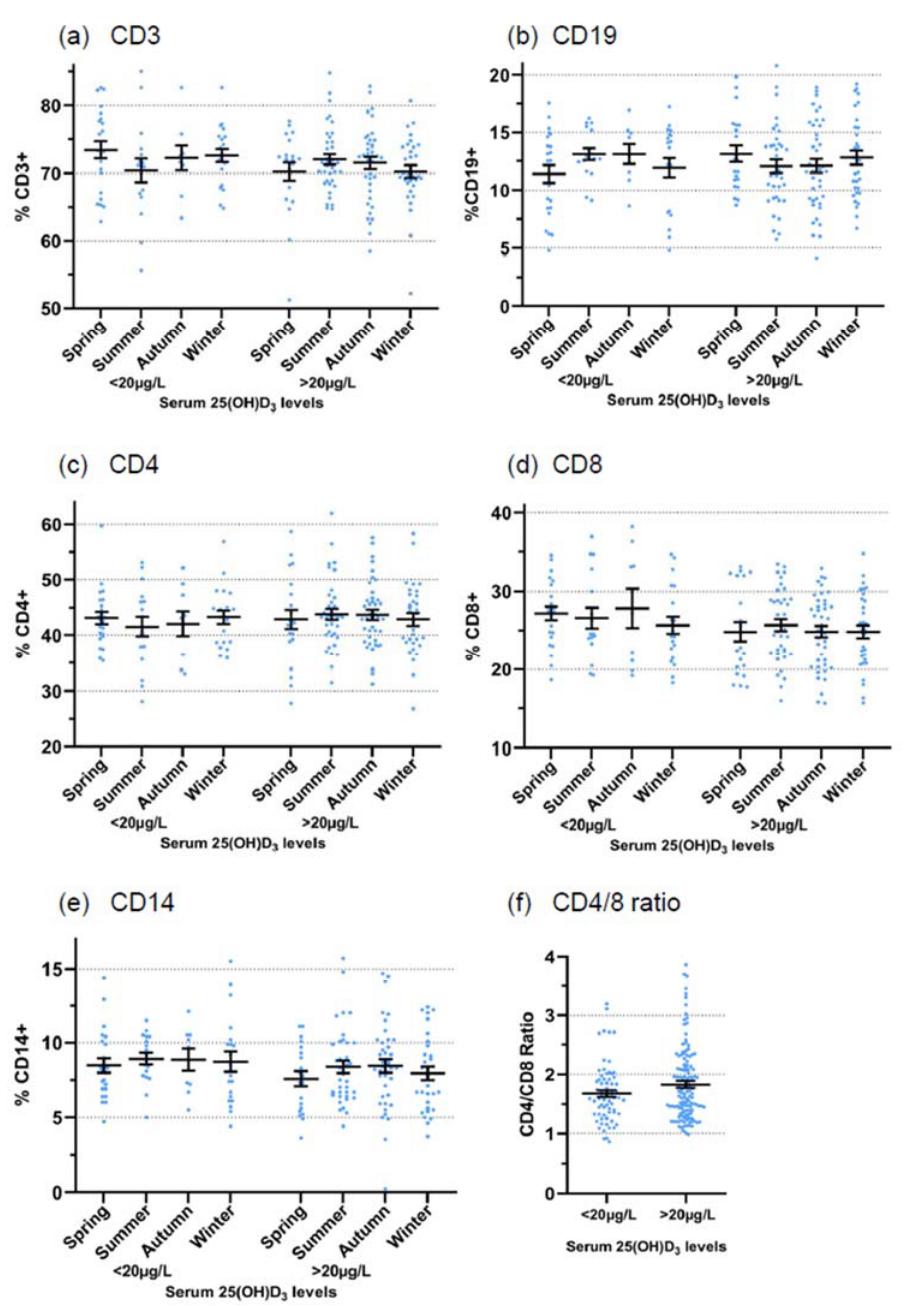
Figure 4. Seasonal variation of immune cell subsets and correlation with serum 25(OH)D 3 levels. Proportions of CD3 ( a ), CD19 ( b ), CD4 ( c ), CD8 ( d ), and CD14 ( e ) cells were measured in blood samples from all donors in the prospective study. Mean values ± SEM and individual data points are displayed according to the season and according to the serum level of 25(OH)D 3 : low (left panels: <20 μ g/L), normal (right panels: >20 μ g/L). ( f ) CD4/CD8 ratio according to serum 25(OH)D 3 levels (all donors, all time points). Statistical comparison in (f) was made by Mann–Whitney U test but did not reach significance.